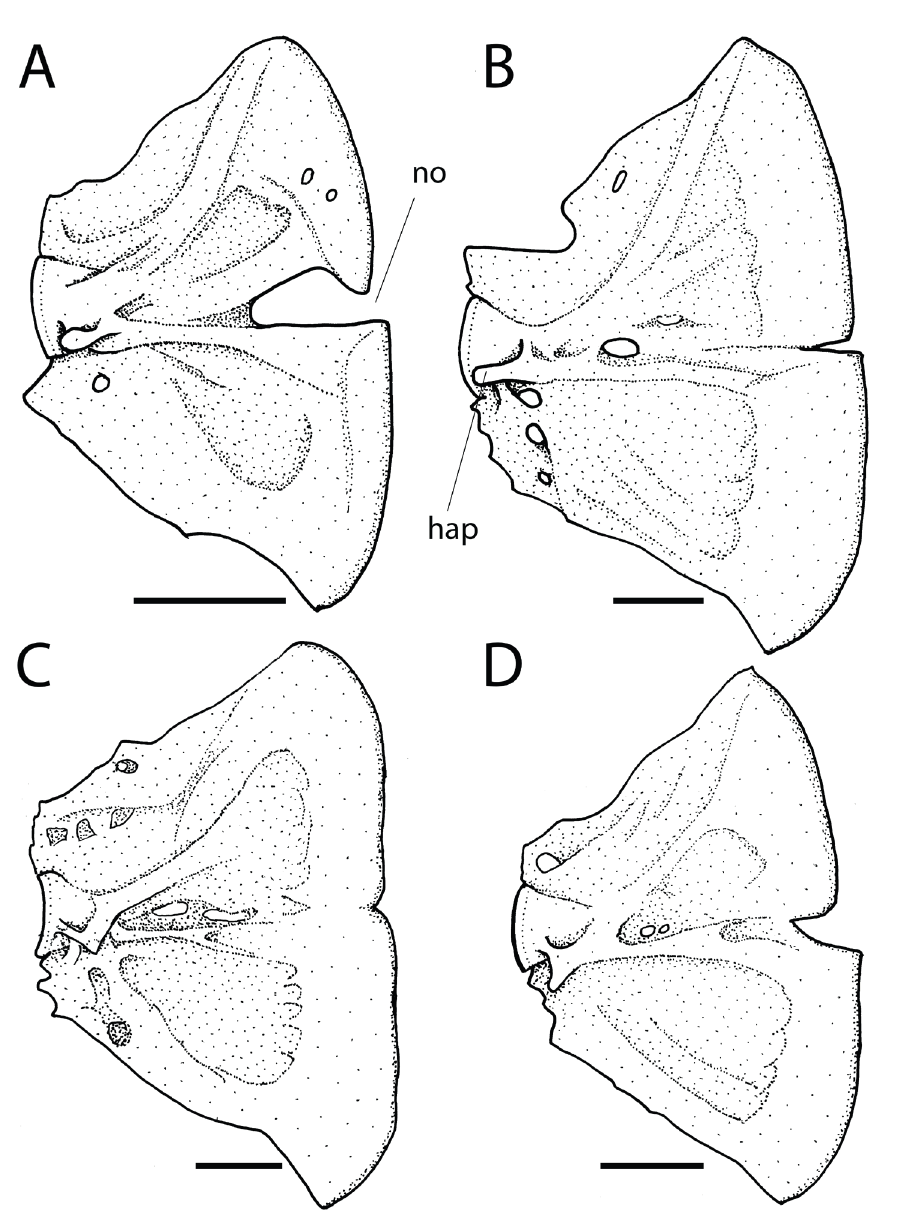
FIGURE 2 | Pareiorhaphis species from the upper